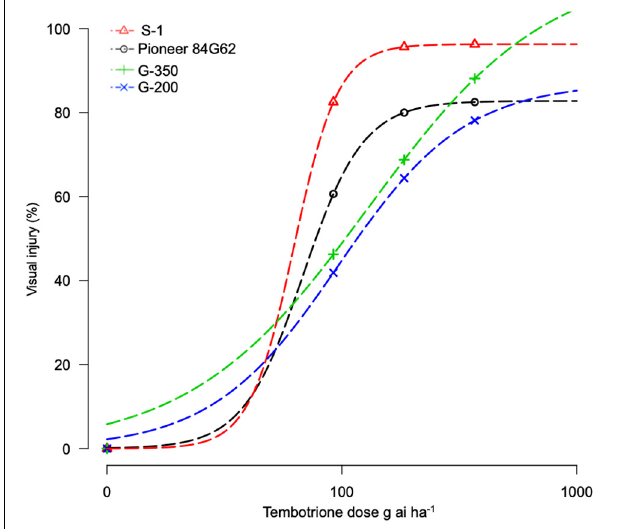
FIGURE 2 | Tembotrione dose-response curves representing the percent injury of S-1 (susceptible), Pioneer 84G62 (commercial hybrid), G-200, and G-350 (resistant genotypes) in response to different doses of tembotrione at 2 weeks after treatment under field